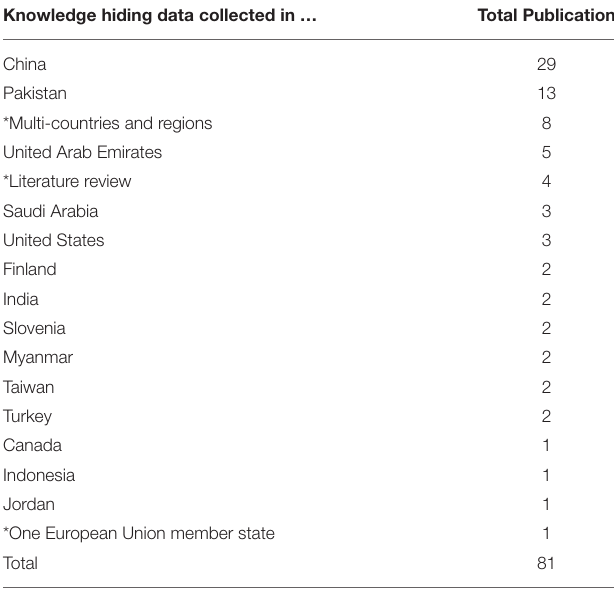
TABLE 4 | Locations from which researchers have collected knowledge hiding